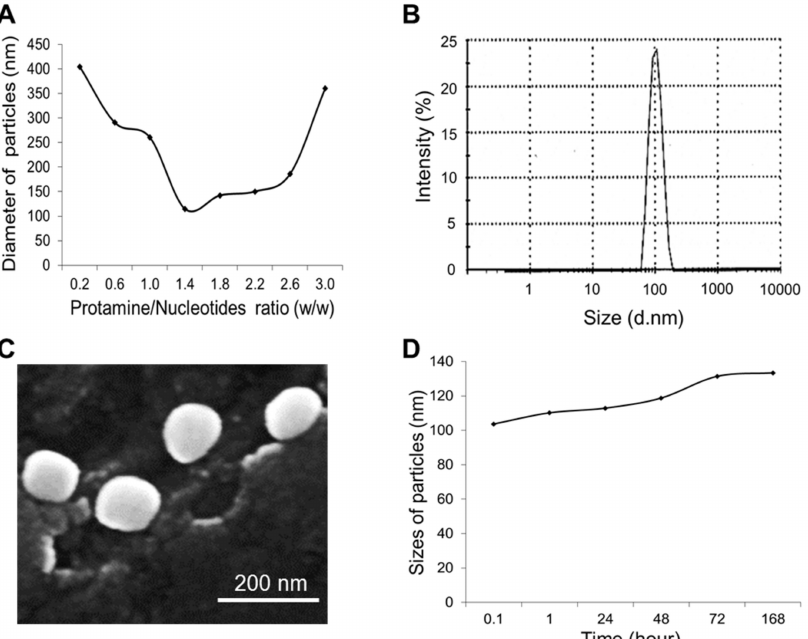
Figure 2. Characterization of protamine nanoparticles. ( A ) Fabrication of nanoparticles at di ff erent ratios of protamine to nucleotides, weight / weight ( w / w ). The most compact nanoparticles were fabricated at a 1.5:1 ratio of protamine to nucleotides. ( B ) Dynamic light scattering measurement (DLS) of the protamine nanoparticles detected a peak size of 103 nm. ( C ) Scanning electronic microscopy revealed uniform protamine nanoparticles with the size consistent with DLS measurement. ( D ) Stability study of protamine nanoparticles by DLS measurement to kinetically monitor size changes up to seven days post-production, ranging from 103 nm to 133 nm. The data shown represent three independent experiments with similar